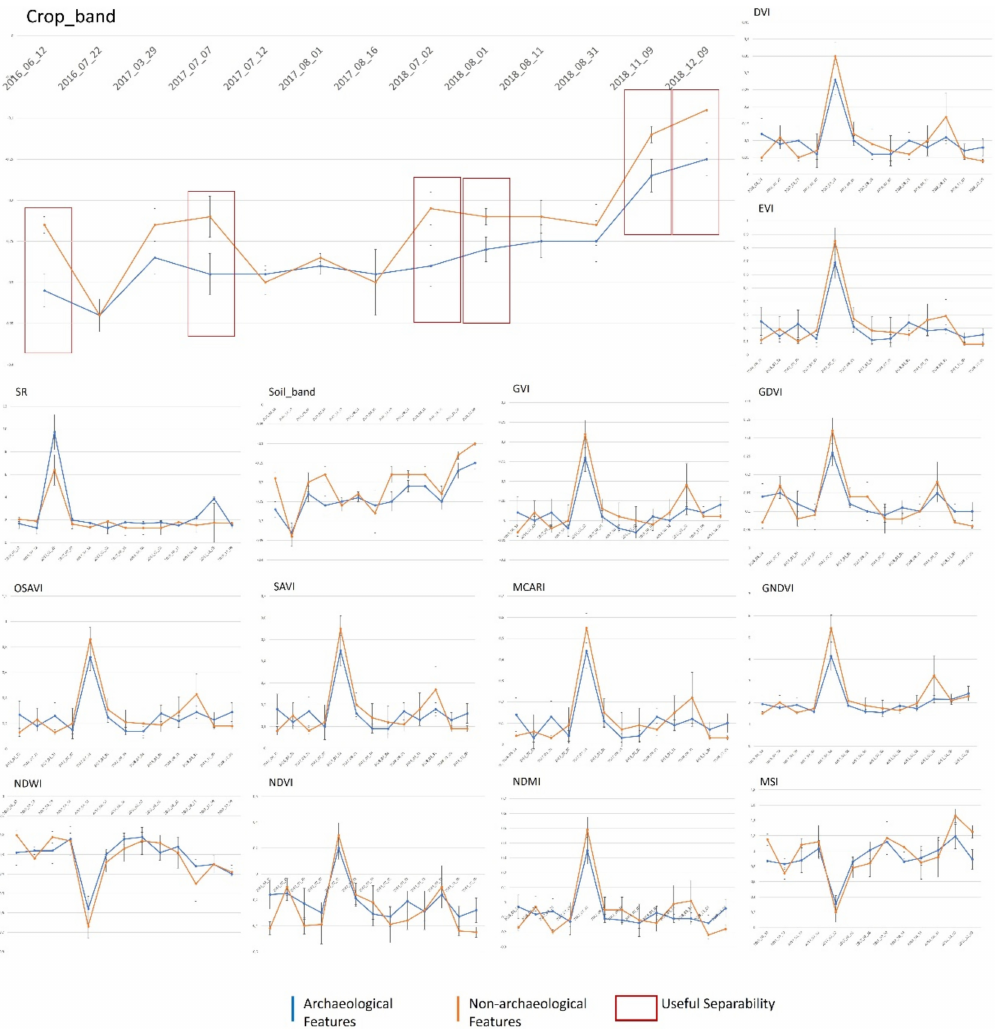
Figure 6. Time Series Analysis and Spectral Un-mixing results on